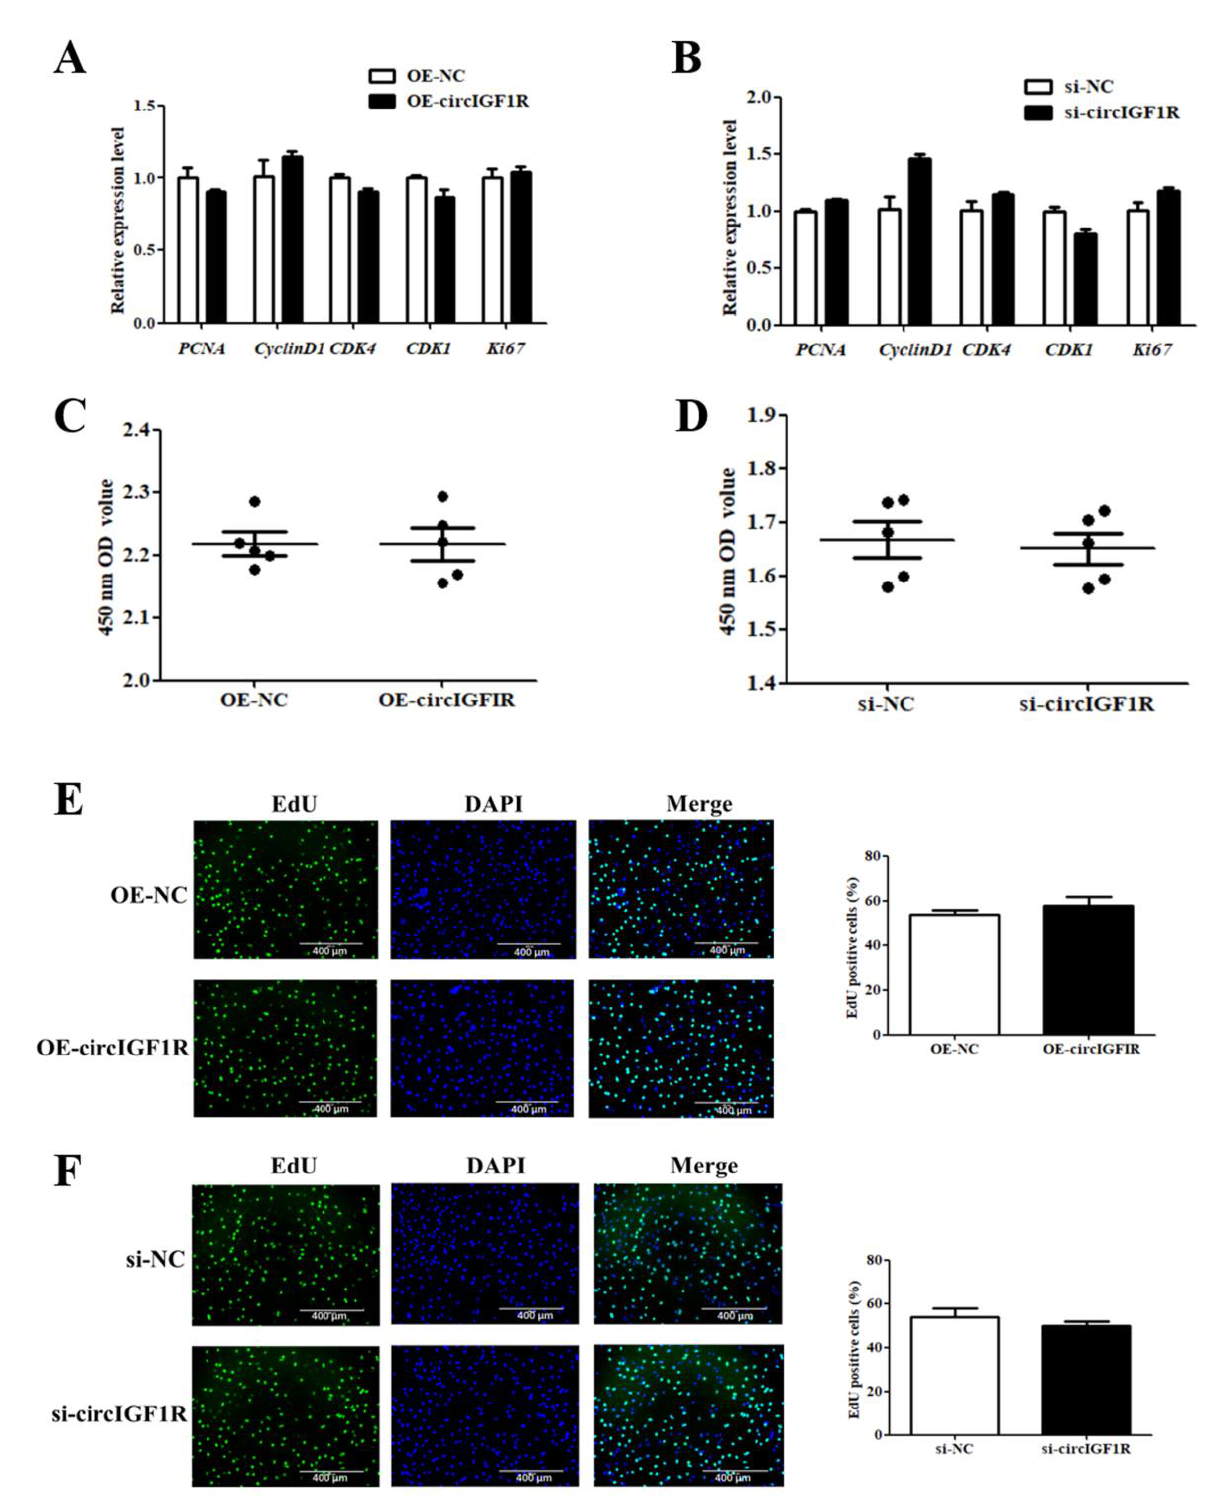
Figure 5. Effect of circIGF1R on the proliferation of porcine SMSCs. ( A , B ): Expression level changes of genes related to cell proliferation. ( C , D ): The results of CCK8. ( E , F ): The results of EdU.